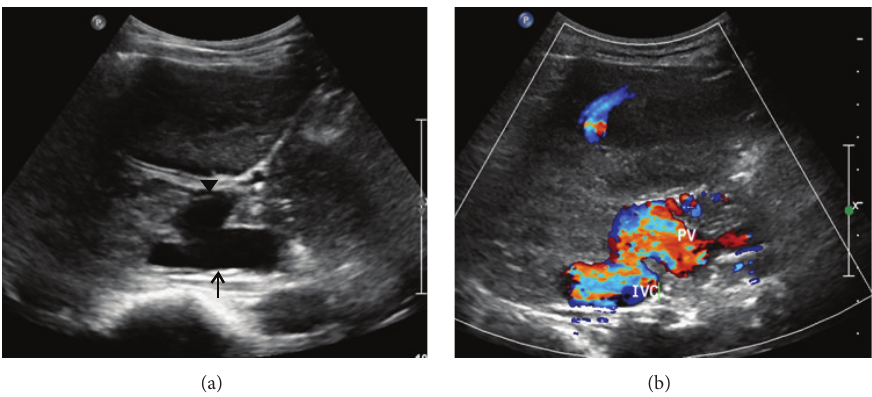
Figure 2: A 4-year-old boy with vague upper abdominal pain and abdominal distension since he was 2 years old. Gray-scale image (a) shows an abnormal communication between inferior vena cava (arrow) and main portal vein (arrow head). Color Doppler (b) image confirms the abnormal communication by demonstrating flow between inferior vena cava (IVC) and main portal vein